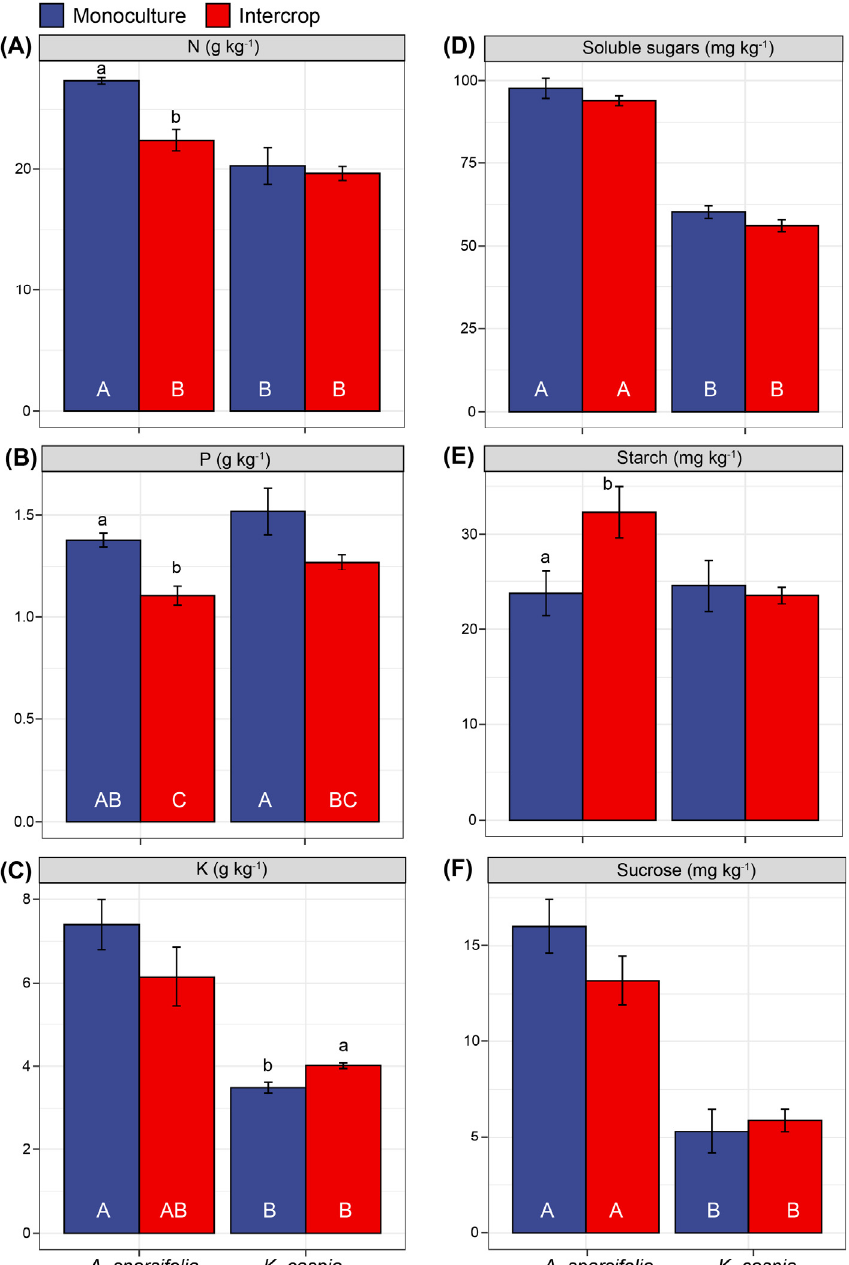
Figure 5. The concentrations of foliar ( A ) total N, ( B ) total P, ( C ) total K, ( D ) soluble sugars, ( E ) starch, and ( F ) sucroseof A. sparsifolia and K. caspia monoculture and their intercrop patterns (four groups). Values are means ± SE (n = 5). Different capital letters below the bars indicate significant differences at p < 0.05 among four treatments, and lowercase letters above error bars indicate significant differences from different planting